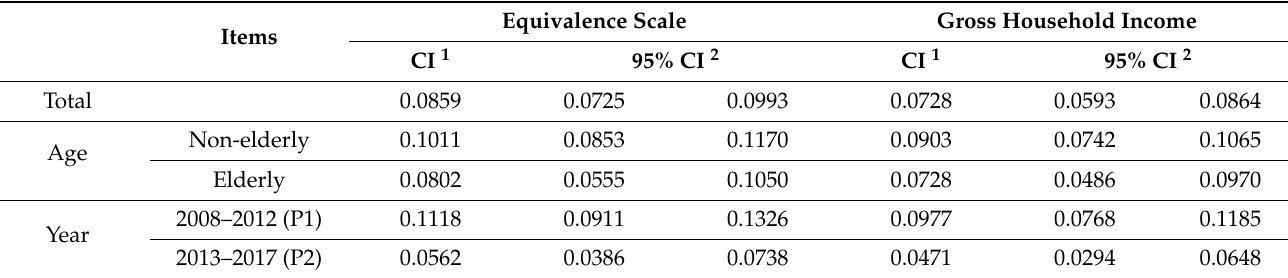
Table 3. Concentration indices (CI) for dental out-of-pocket expenditures by age group and time period.